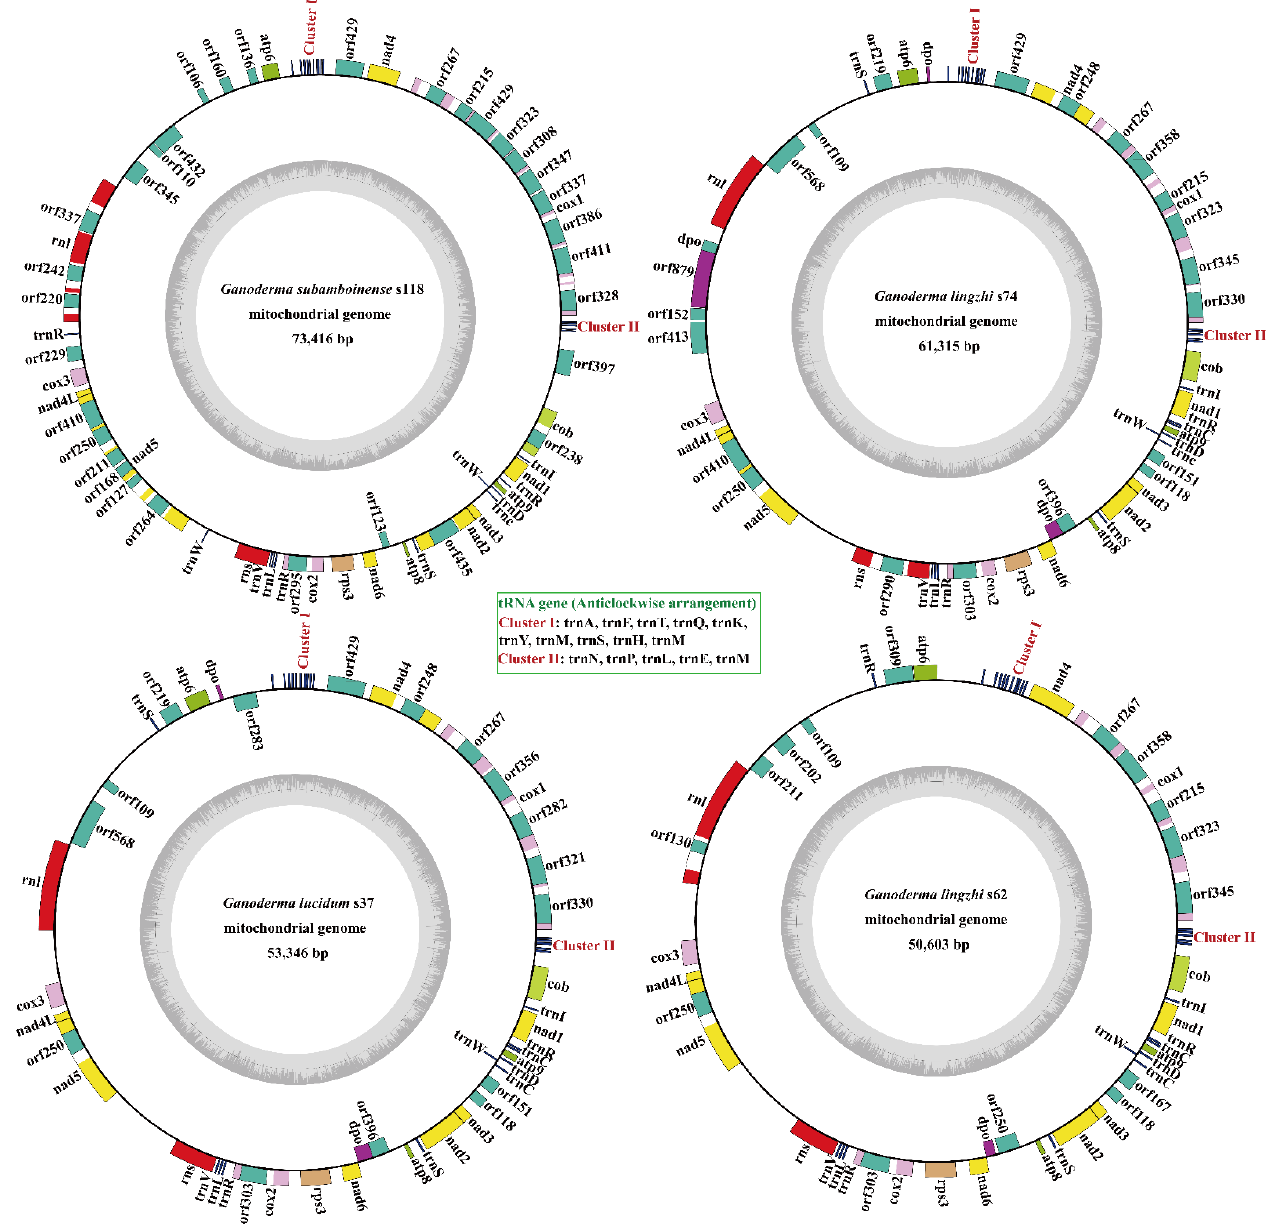
Figure 1. Circular maps of the four Ganoderma mitogenomes. Genes are represented by different colored blocks. Colored blocks outside each ring indicate that the genes are on the direct strand while colored blocks within the ring indicate that the genes are located on the reverse strand.